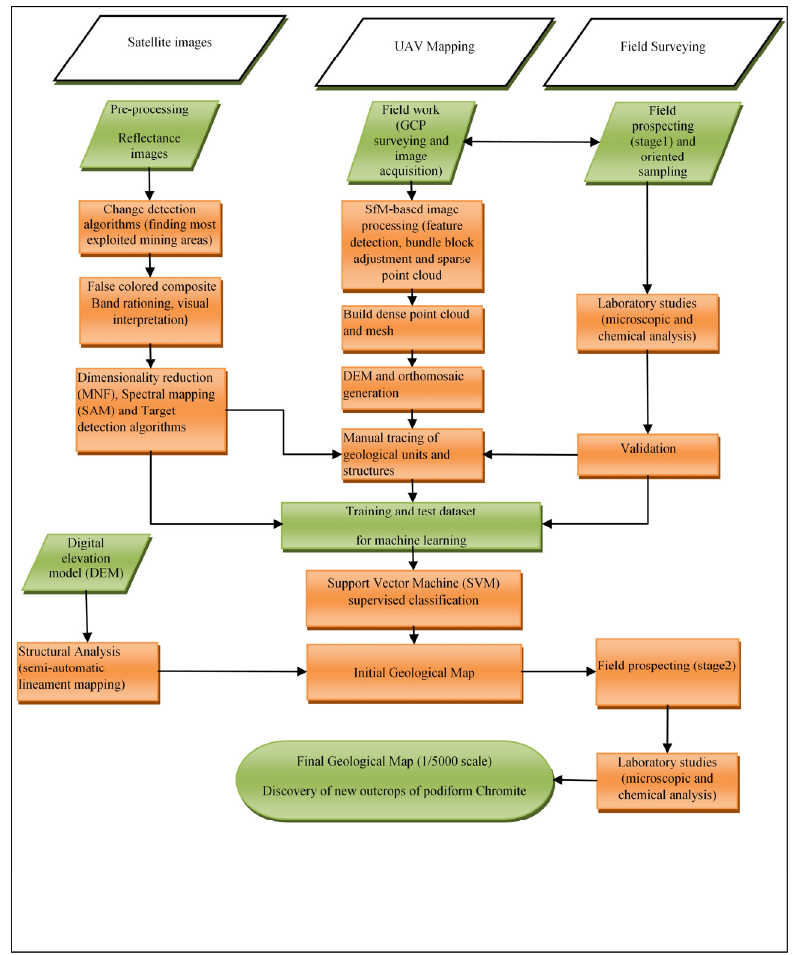
Figure 2. The flowchart of processing stages including satellite remote sensing, UAV mapping, and field surveying for prospecting podiform chromites.